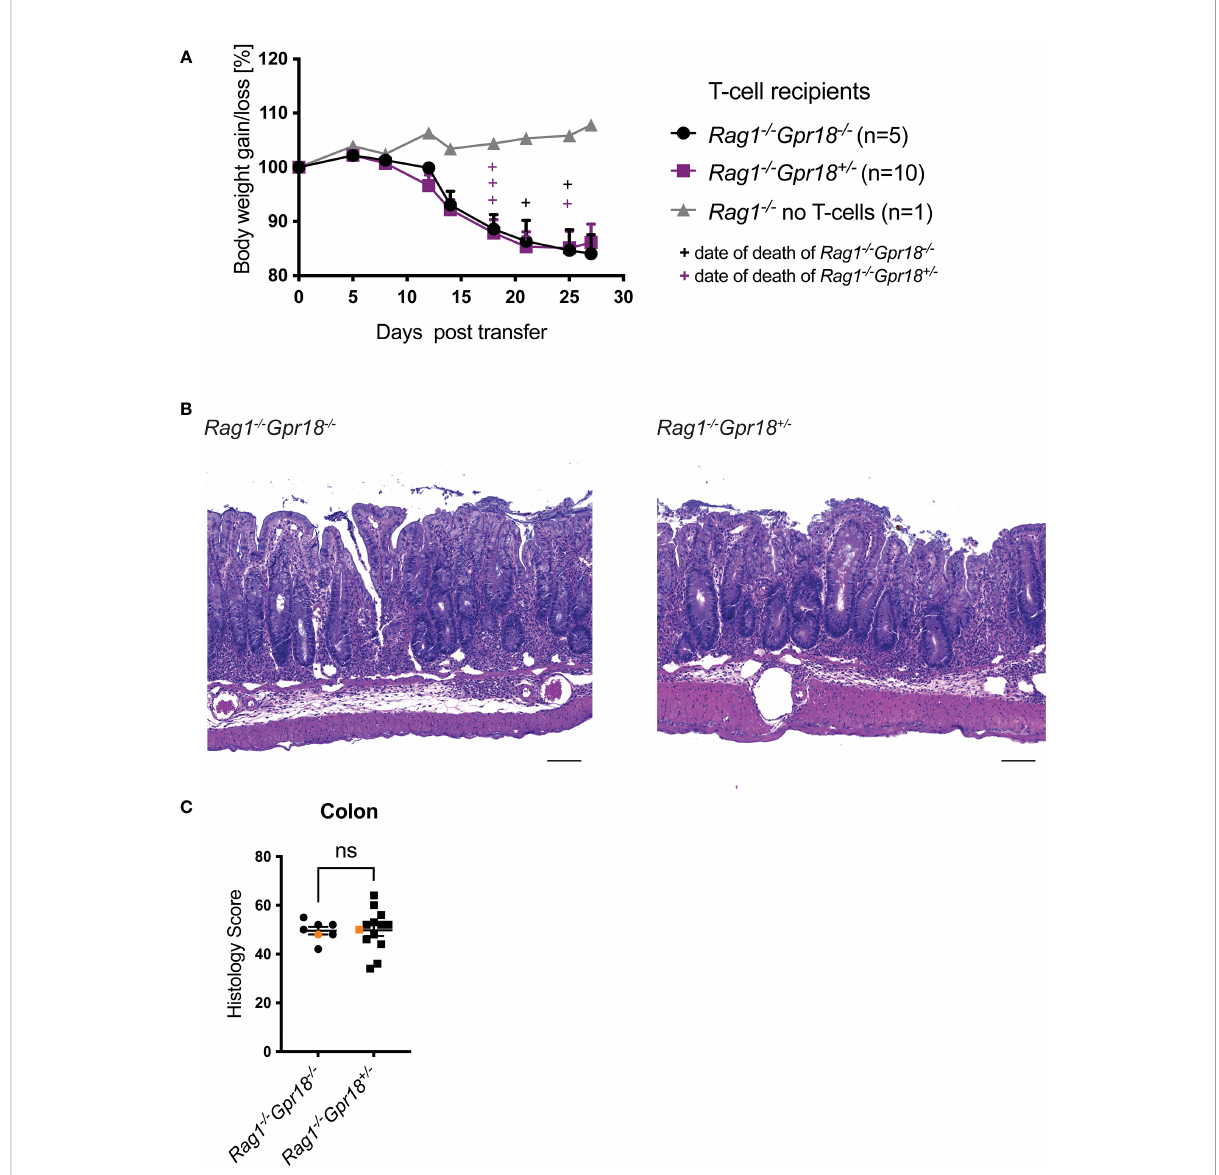
FIGURE 5 GPR18 does not play a role on innate cells in the T cell transfer host. Colitis was induced by adoptive transfer of naive CD4 + T cells from C57BL/ 6 mice into GPR18 de fi cient ( Gpr18 -/- ) vs. control ( Gpr18 +/- ) Rag1 -/- recipients. Disease progression was monitored. (A) Weight change was monitored 2-4 times per week as % starting body weight. A representative weight graph of 3 independent experiments is shown. The weight of dead mice was carried forward, indicated with + signs in magenta for control and in black for Rag1 -/- Gpr18 +/- mice. (B) H&E staining of representative colon sections (middle part of whole colon) at 40x (scale bar 100 m m) magni fi cation. (C) Blinded histology score from the middle part of whole colon of 3 independent experiments combined. Representative images were taken from mice represented by the orange colored data points. Error bars represent S.E.M. Two-way ANOVA (Tukey ’ s test) (A) and nonparametric T-test (Mann-Whitney test) (C) . ns, not signi fi